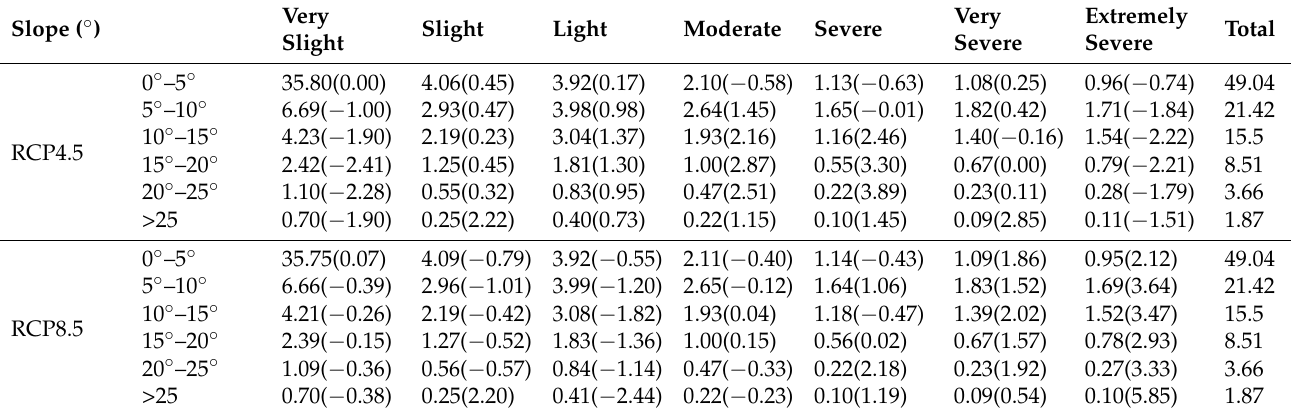
Table 6. Soil erosion area percentage (%) of different slope